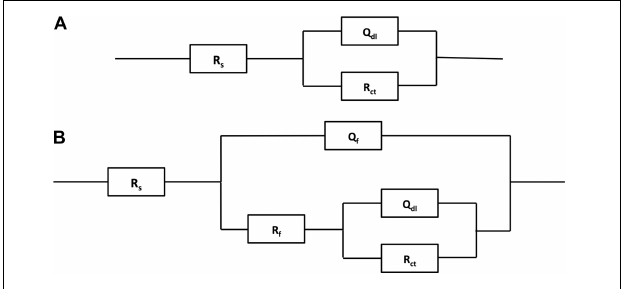
FIGURE 8 | Electrochemical equivalent circuits for fitting the measured impedance data in Figure 7 .